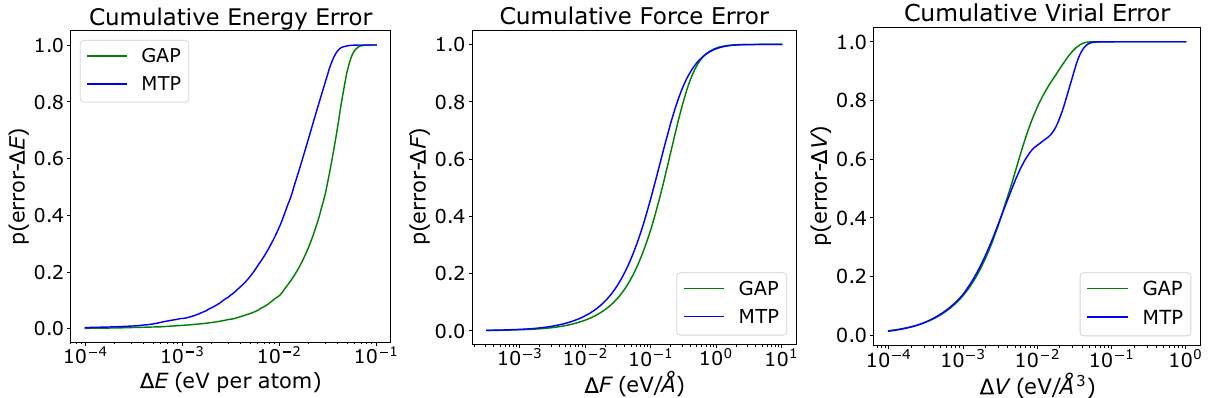
Fig. 1 Cumulative probability of error plots for the liquid dataset. The liquid dataset consists of ~6000 con fi gurations from a subsampled MD run. From left to right, energy, force, and virial error probabilities are plotted, where the error is calculated relative to DFT. Mean errors are given in Table 5.